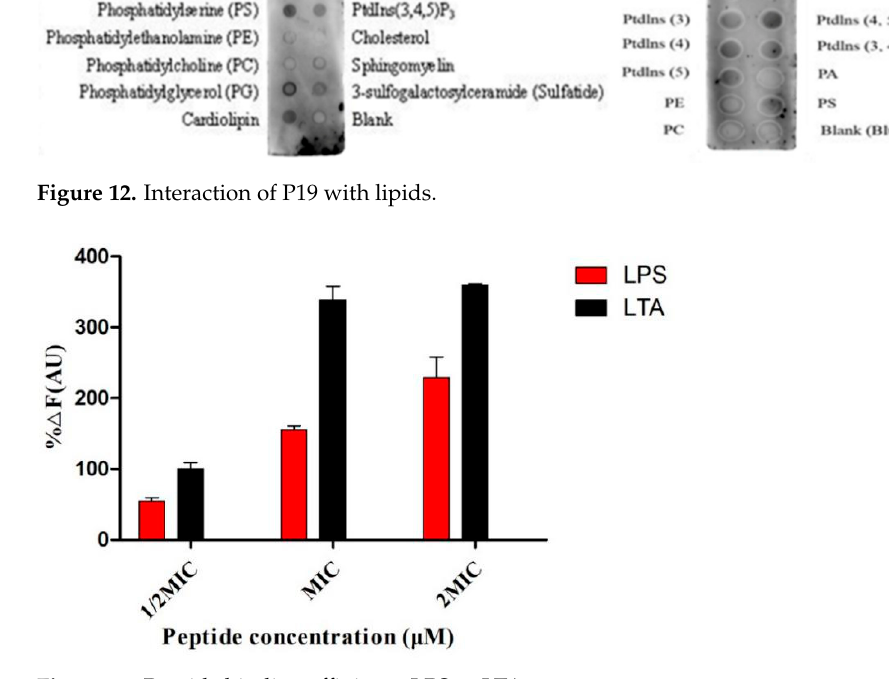
Figure 13. Peptide binding affinity to LPS or LTA.